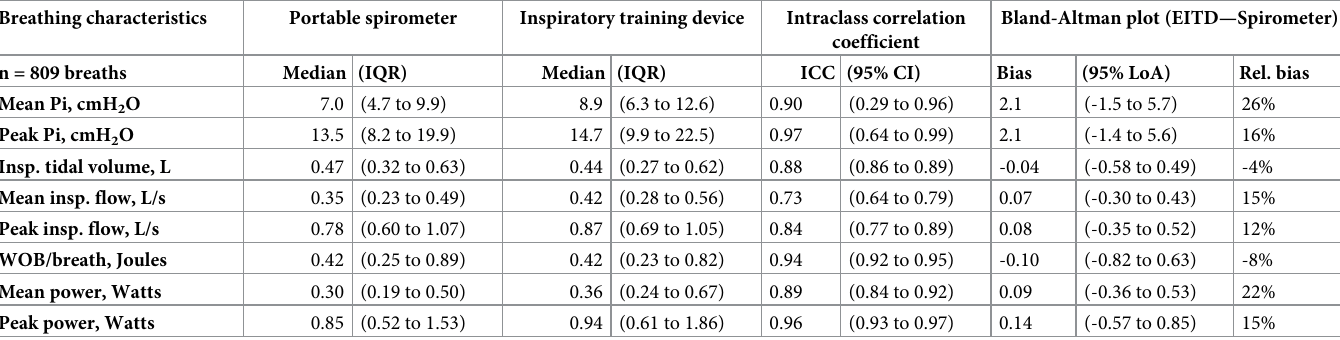
Table 2. Agreement between the